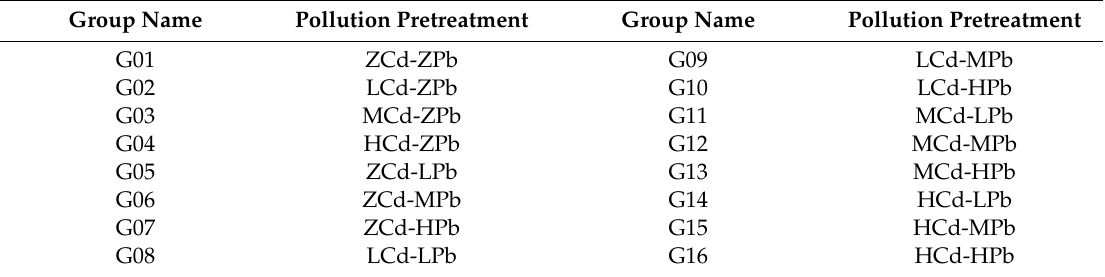
Table 1. Pollution pretreatments of di ff erent